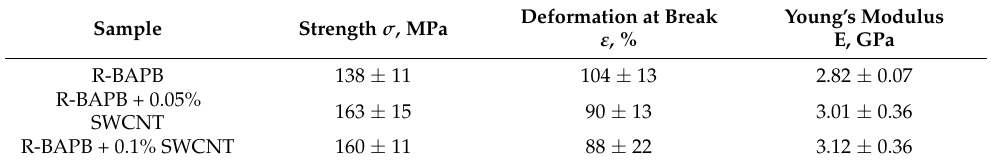
Table 1. Mechanical properties of unfilled amorphous R-BAPB and SWCNT-R-BAPB nanocomposite of fibers with different SWCNT mass fractions in the amorphous state. The results were obtained using experimental